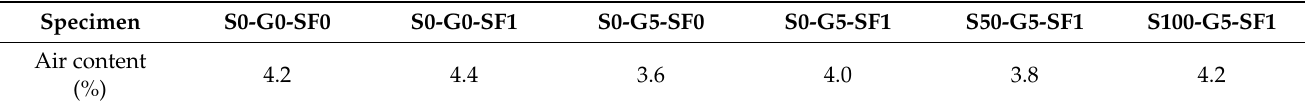
Table 6. Air content results.